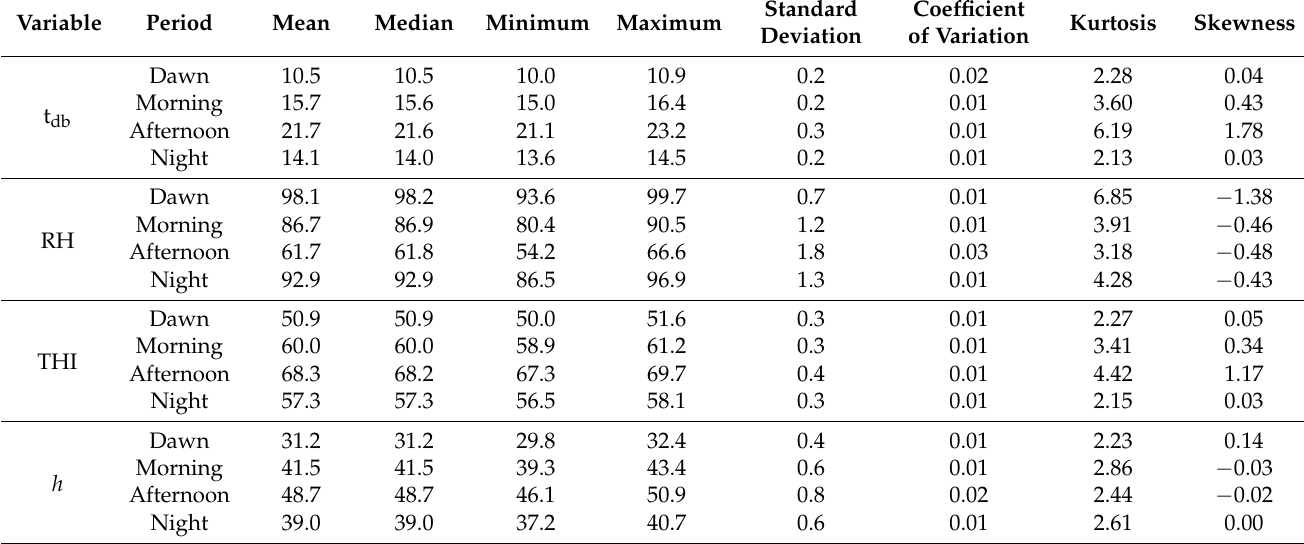
Table 2. Descriptive analysis of the average hourly values of the variables dry-bulb air temperature (t db , in ◦ C), relative humidity (RH, in %), temperature and humidity index (THI), and